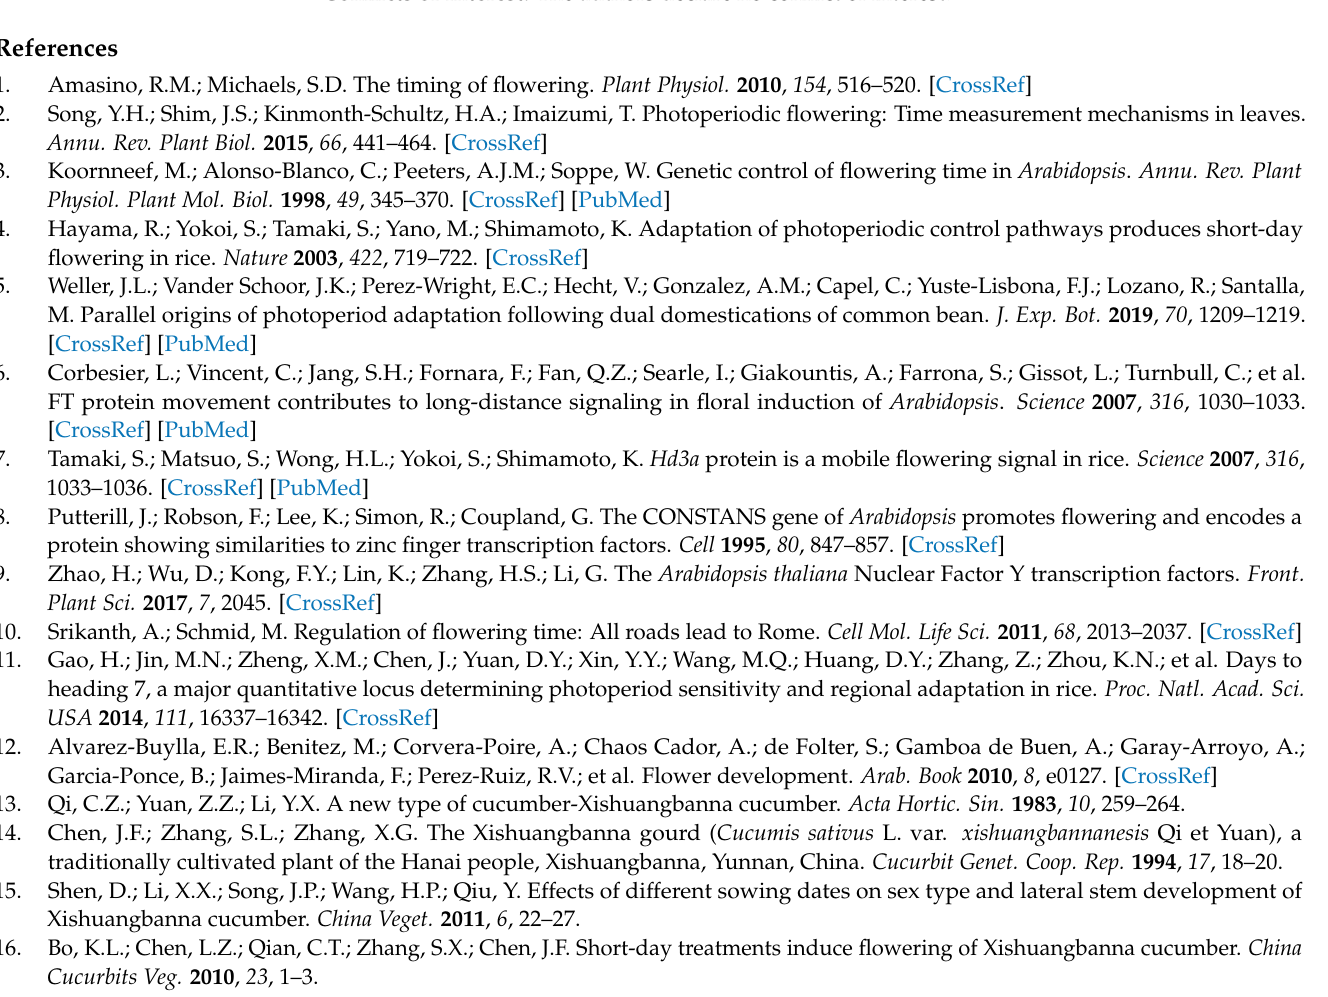
DEGs. Table S9: The expression levels of DEGs involved in transcription factors. Table S10: The expression level of genes participating into